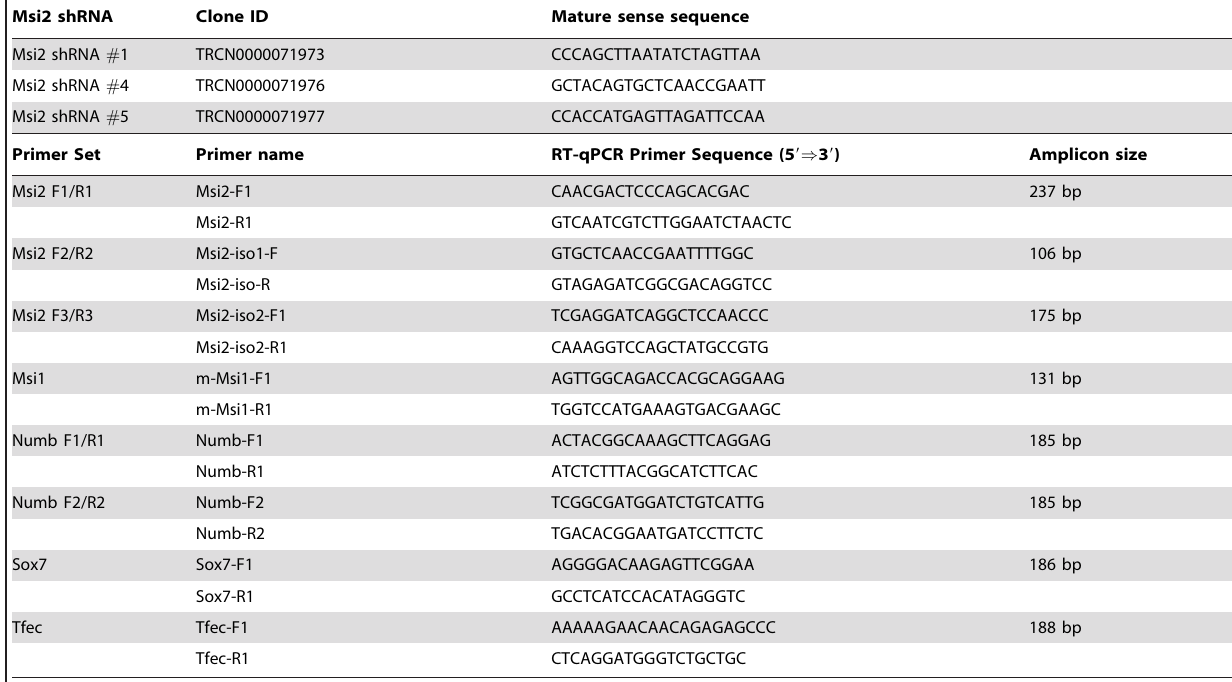
Msi2 shRNA Clone ID Mature sense